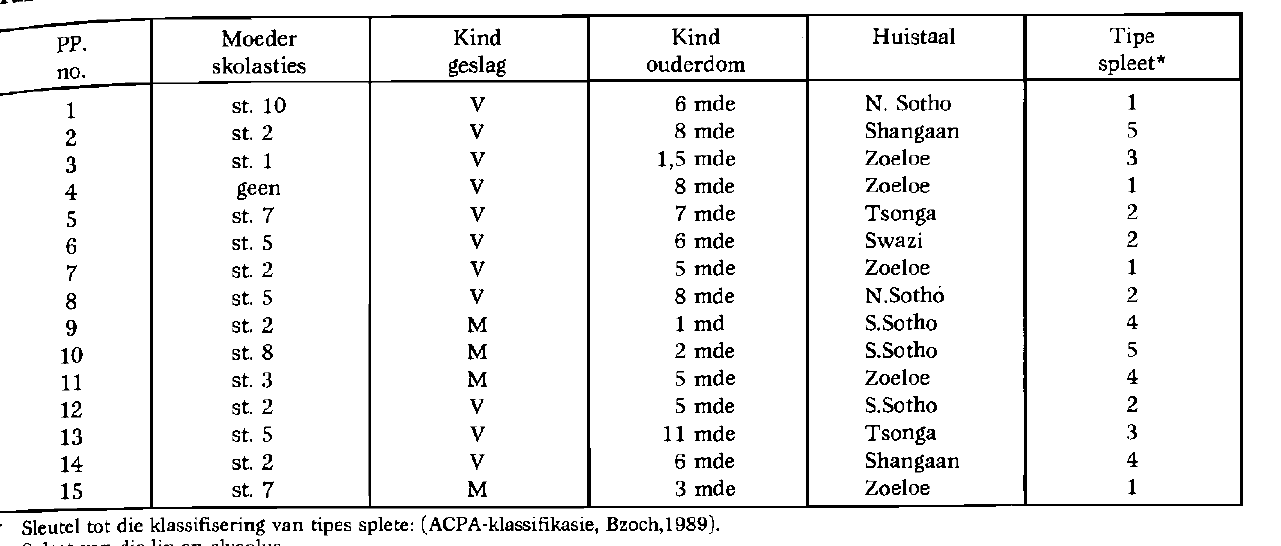
Tabel 1: Algemene becld van die proefpersone wat by hierdie ondersoek be trek is.